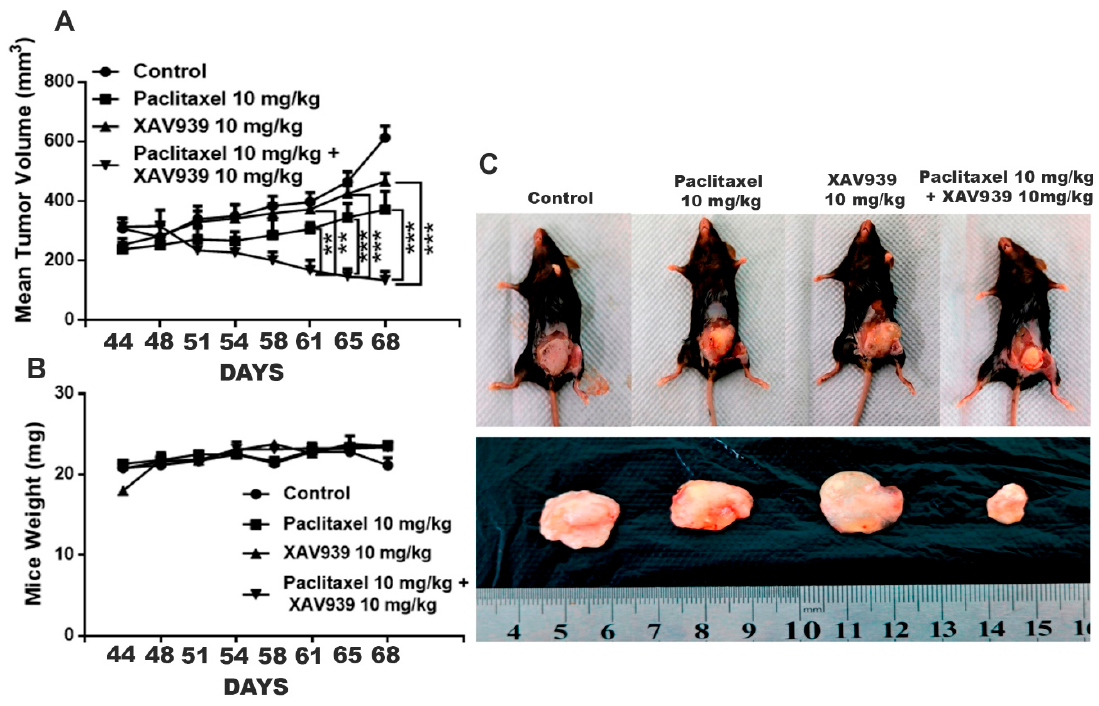
Figure 8. Combination treatment with paclitaxel and XAV939 suppressed the pristane-induced breast tumor in an in vivo mouse model. ( A ) The pristane-induced tumor was generated in C57 female mice, and paclitaxel (10 mg / kg), XAV939 (10 mg / kg), and a combination of paclitaxel + XAV939 (10 mg / kg + 10 mg / kg) were injected at a pristane-induced tumor site twice a week for 4 weeks. ( A , B ) Mouse tumor volume and body weight were measured every two weeks. Data were presented at mean ± SD (n = 3; **: p < 0.005 and ***: p < 0.0005, compared to each single treatment with paclitaxel or XAV939). ( C ) After 4 weeks, mice were sacrificed, and tumors were isolated and photographed.